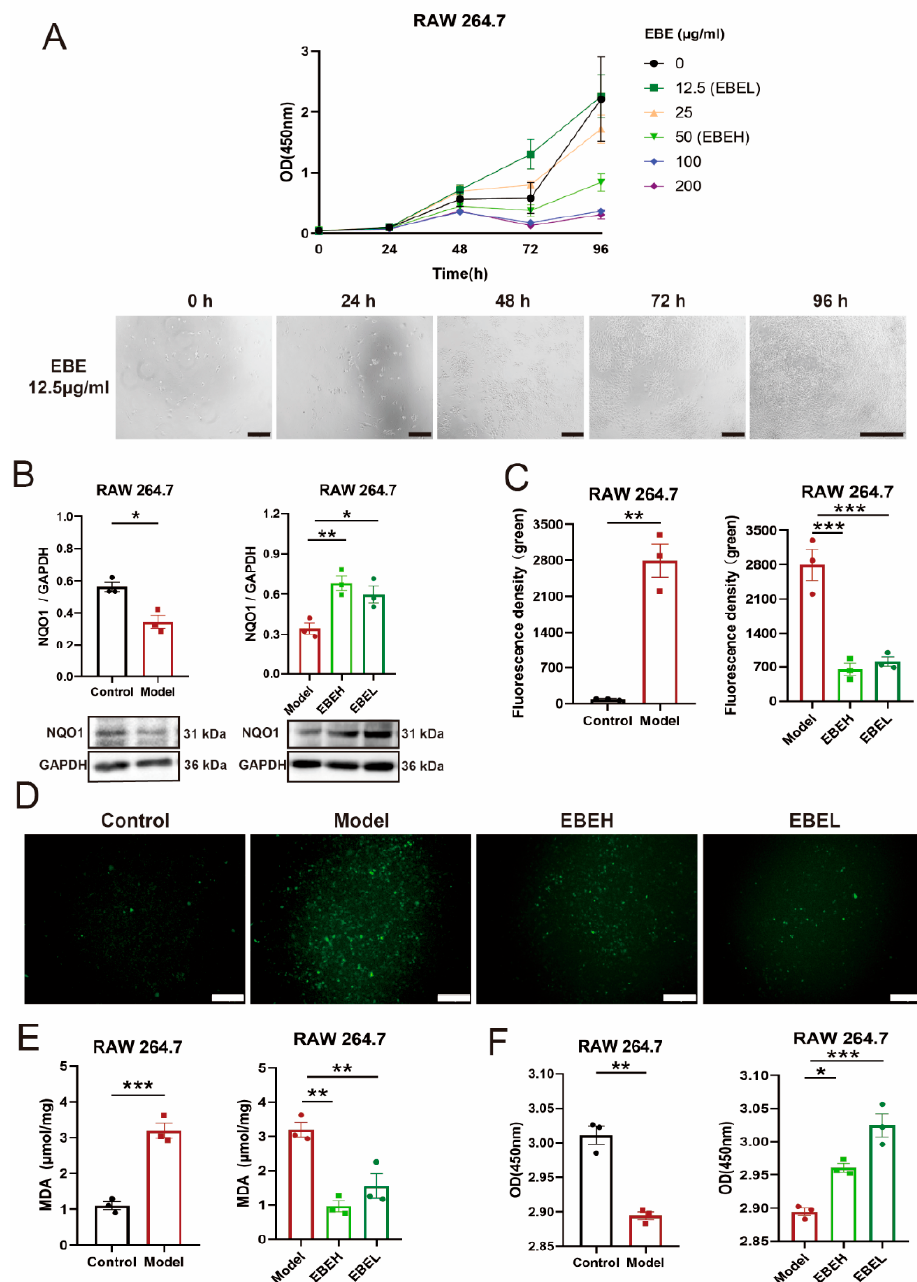
Figure 4. EBE alleviated oxidative stress of cells model by NQO1. ( A ) The effect of several concen- trations of EBE on RAW 264.7 viability at different times. Scale bars of 0–72 h, 200 μ m. Scale bars of 96 h, 400 μ m. ( B ) NQO1 expression of cells for RAW 264.7 of vehicle treatment (Control), RAW 264.7 of LPS treatment (Model), model of 50 μ g/mL EBE treatment (EBEH) and model of 12.5 μ g/mL EBE treatment (EBEL), as measured by western blotting. ( C ) ROS content of cells for Control, Model, EBEH, and EBEL. ( D ) Representative fluorescence images of cells for Control, Model, EBEH, and EBEL. Green, ROS. Scale bar, 200 μ m. ( E , F ) MDA level ( E ) and viability of cells ( F ) for Control, Model, EBEH, and EBEL. Unpaired t -test and ordinary one-way ANOVA were used on experimental data. Data are presented as mean ± SEM, n = 3. * p < 0.05, ** p < 0.01, *** p < 0.001.